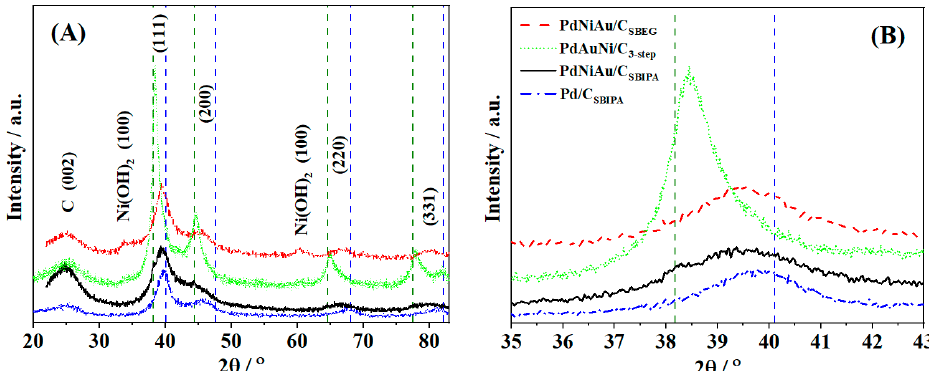
Figure 1. ( A ) XRD patterns of PdAuNi/C SBEG , PdAuNi/C SBIPA , Pd/C SBIPA , and PdAuNi/C 3-step and ( B ) the enlarged (111) facet for the four catalysts.